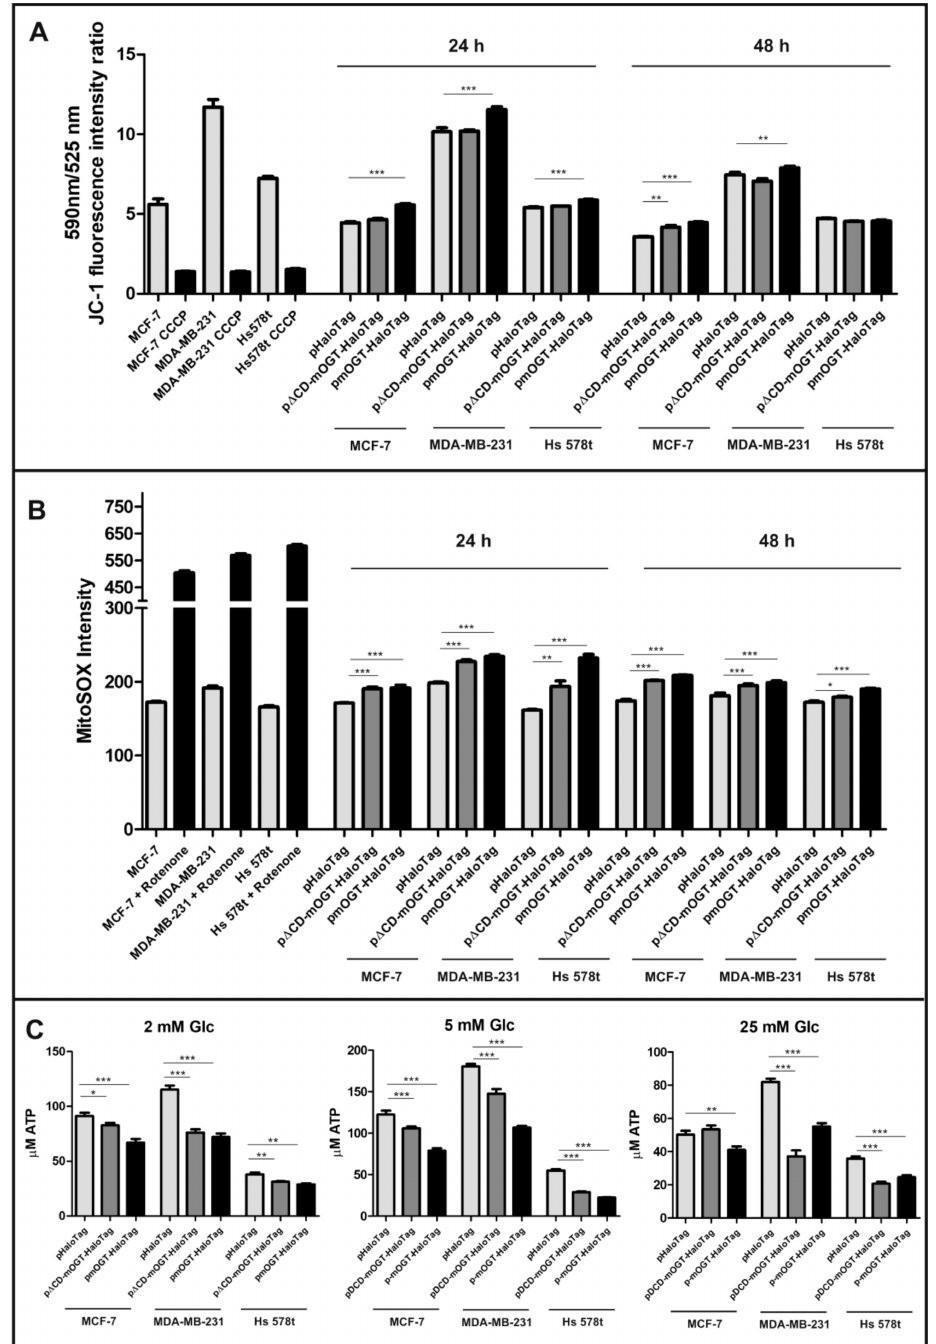
Figure 3. Elevated mOGT level impairs mitochondria homeostasis and ATP production. ( A ) Determination of mitochondrial transmembrane potential 24 or 48 h after transient transfection of cells with plasmid DNA. The 590/525 nm fluorescence intensity ratio of JC-1 dye is presented as a mean +/ − SD. ( B ) Mitochondrial ROS level in transfected cells assessed by using MitoSOX Red mitochondrial superoxide indicator. The bars are shown as a median +/ − SD of fluorescence intensity of cells determined by flow cytometry. ( C ) Intracellular ATP contents in cells treated for 48 h with pHaloTag (control), p ∆ CDmOGT-HaloTag, or pmOGT-HaloTag were determined using a Luminescent ATP Detection Assay Kit. (Data represent the average of at least 3 independent experiments performed in tetraplicate. * indicates significance p < 0.05; ** p < 0.01; *** p < 0.001. CCCP is a chemical agent which allows for complete dissipation of the proton gradient across the mitochondrial inner